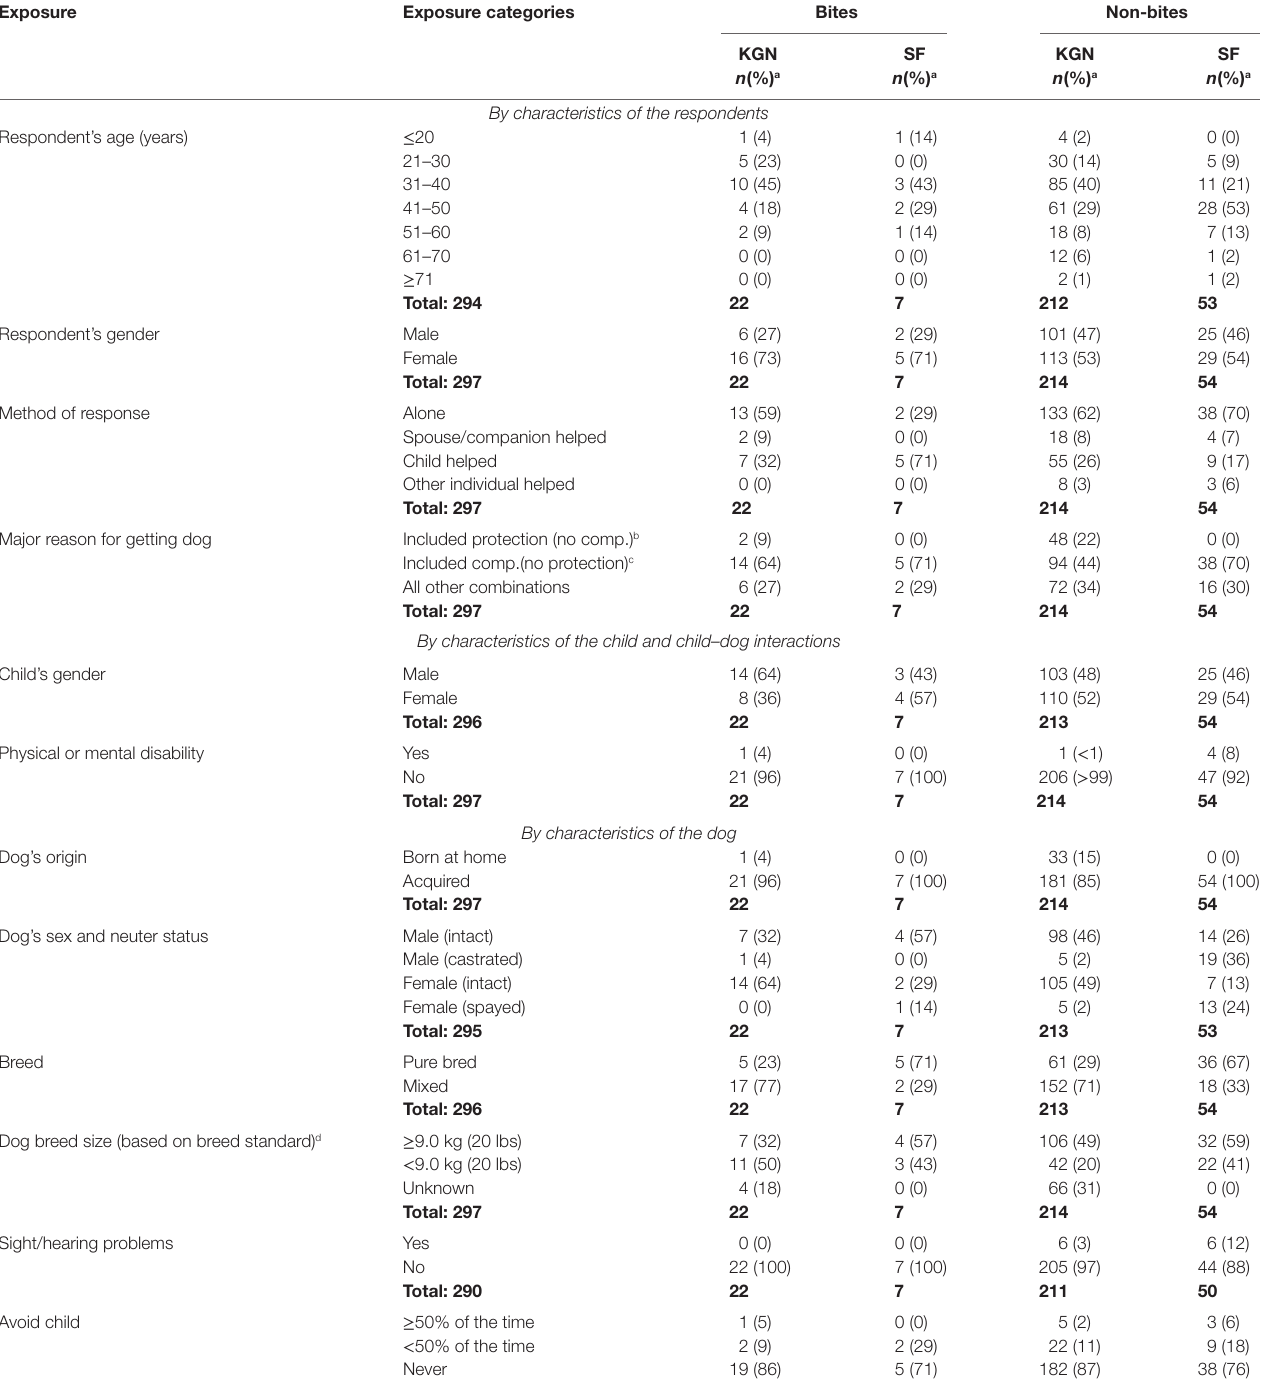
TaBle 3 | Distribution of biting and non-biting dogs by exposure status and city of origin: Kingston (KGN), Jamaica, and San Francisco (SF), USA.